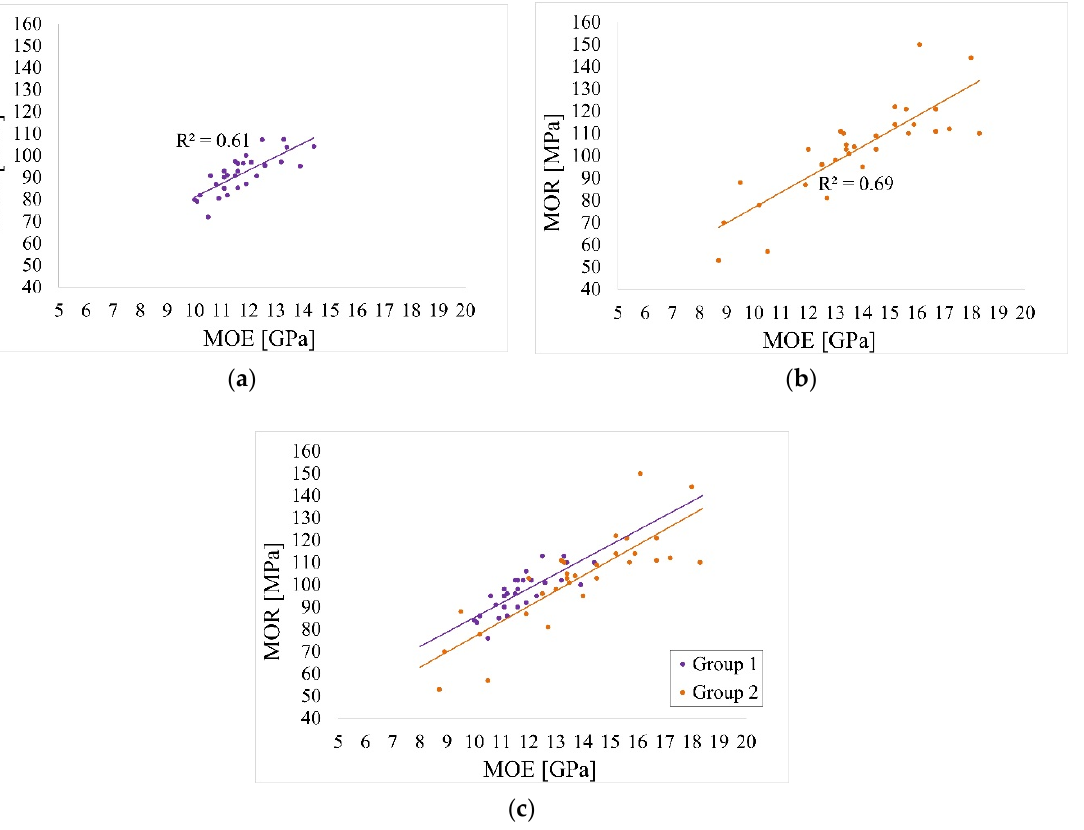
Figure 14. Correlation between MOE and MOR: ( a ) Group 1, ( b ) Group 2, ( c ) both Groups. Table 15. Results of small clear specimen bending tests.